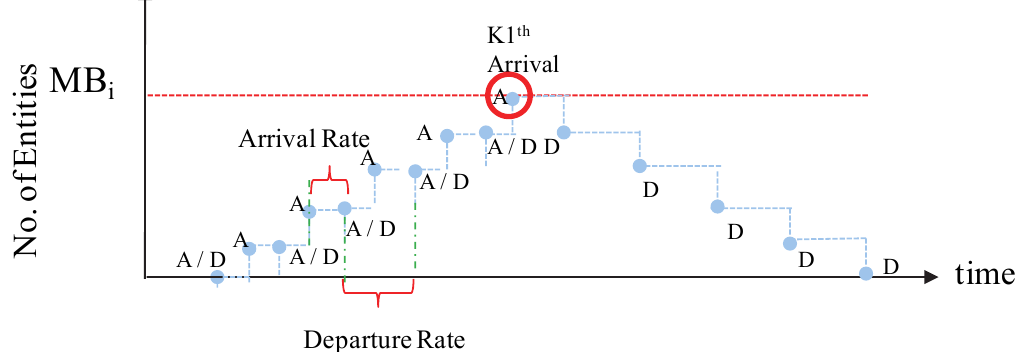
Fig. 5. Maximum number of entities that buffer B i will experience given inventory